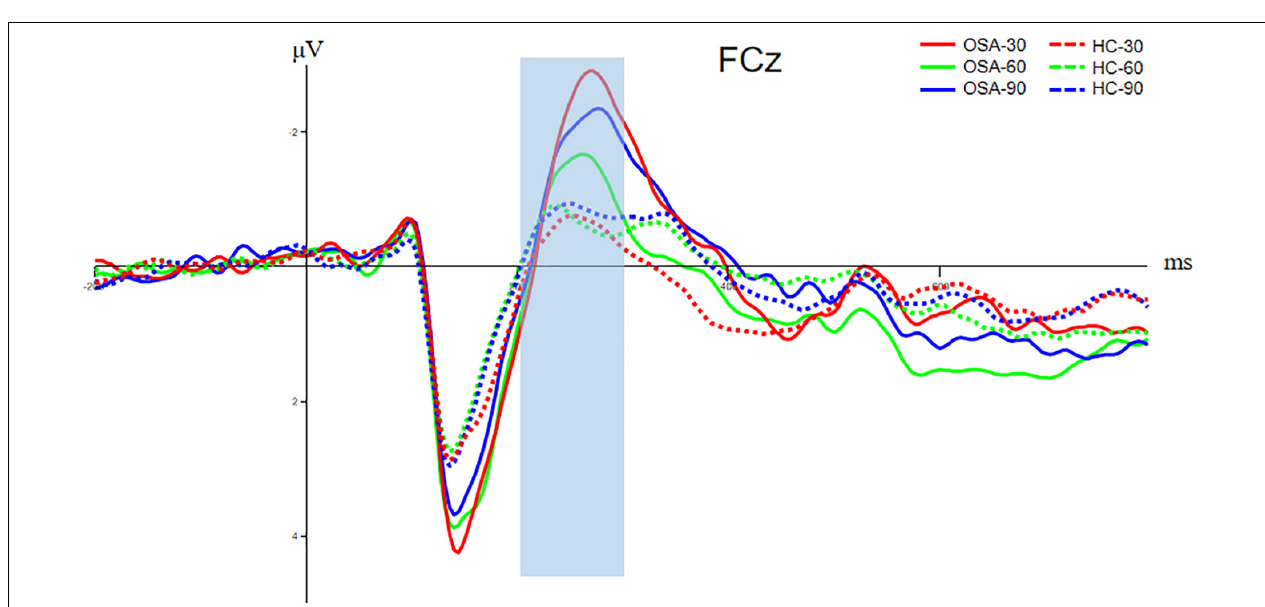
FIGURE 5 | Comparison of N200 components between OSA and healthy control group. The solid line is the OSA group, and the dotted line is the healthy control group. The red, green, and blue lines represent Jitter30, Jitter60, and Jitter90 conditions, respectively.